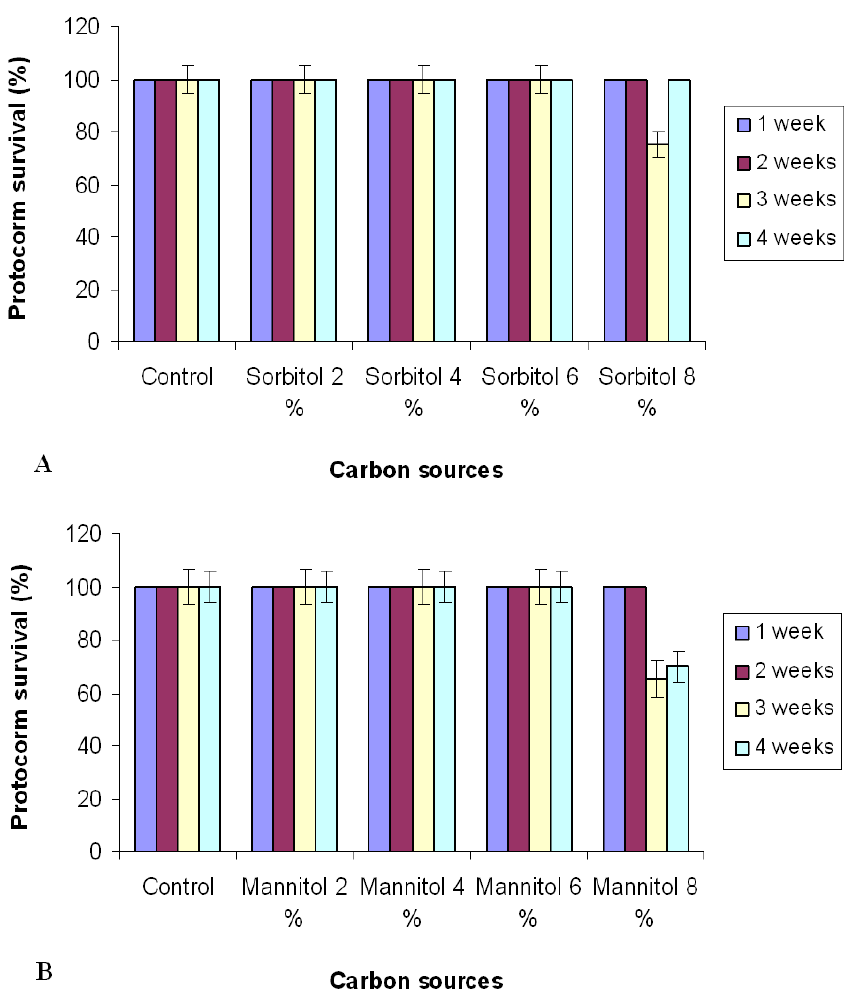
Fig. 2. Regeneration of protocorms after 4 weeks in media with different types and concen- trations of sugar. In each treatment 20 explants were studied. Bar = standard